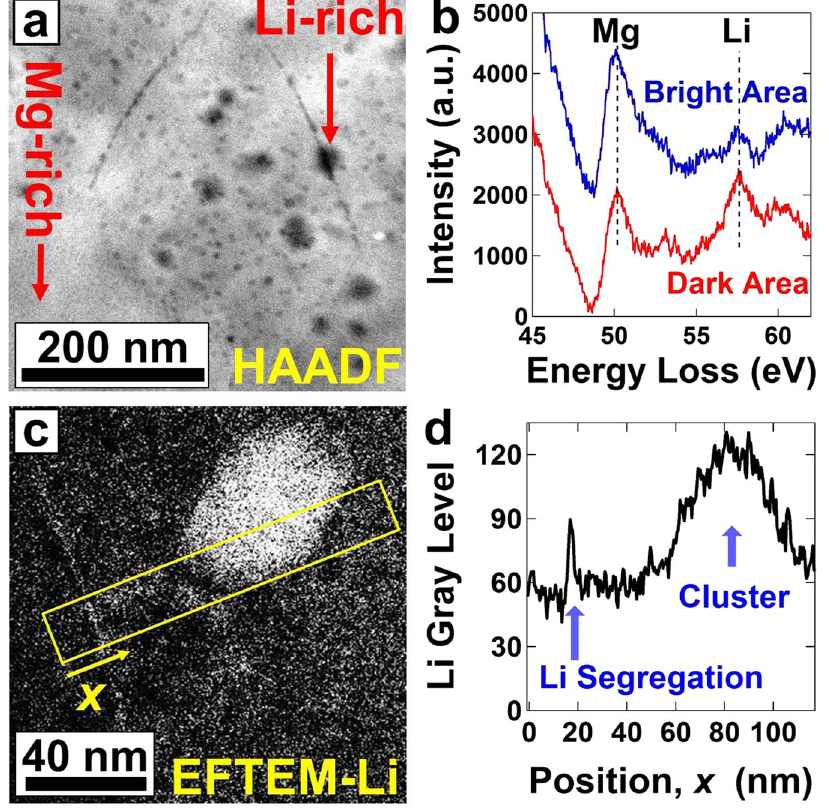
Figure 5. Li segregates along the boundaries in response to SPD processing. Microstructure of the sample processed by N = 200 cycles of SPD. ( a ) HAADF image showing the distribution of Mg and Li atoms. Bright and dark contrasts correspond to the Mg-rich and Li-rich regions, respectively. ( b ) EELS spectra obtained from the bright and dark regions, indicated by arrows, in the HAADF image. Comparison between the peaks for Mg and Li shows the distribution of Mg and Li atoms. ( c ) EFTEM mapping for Li in which the dark and bright contrasts correspond to Mg-rich and Li-rich regions, respectively. ( d ) Changes in the gray level along the x direction in the EFTEM image. An increasing in the gray level corresponds to an increase in the fraction of